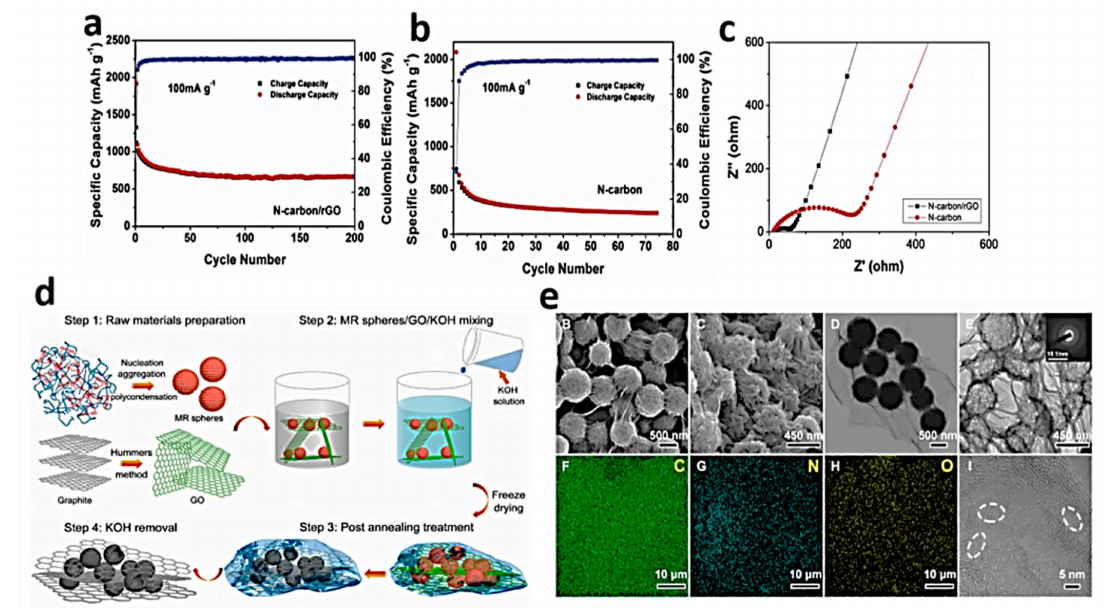
Figure 13. Battery cyclic performance ( a ) N-carbon / rGO; ( b ) N-carbon; ( c ) Nyquist plots for N-carbon / rGO and N-carbon [85], ( d ) schematic depiction of the synthesis procedure of DHCSs / RGO composites, ( e ) SEM images of (B) MR spheres / GO after mixing (C) DHCSs / RGO-700; TEM images (D) MR spheres / GO and (E) DHCSs / RGO-700. (F − H) Elemental mapping of DHCSs / RGO-700 (I) HRTEM image of DHCSs / RGO-700 Reprinted with permission from [52], Copyright ACS Publisher,